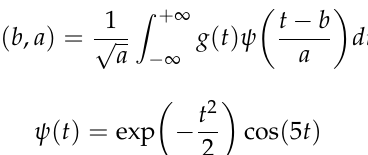
Figure 4. Excitation signal measured in the experimental study.